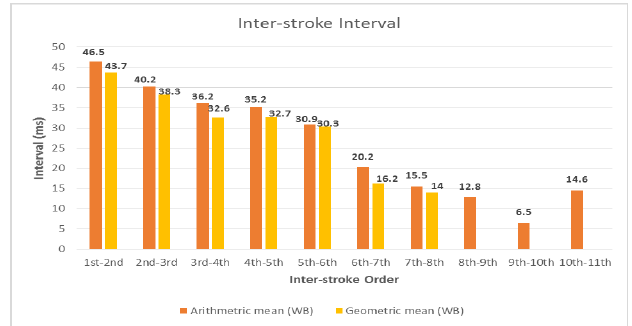
Figure 5. Inter stroke interval of SRS order, WB = wideband.